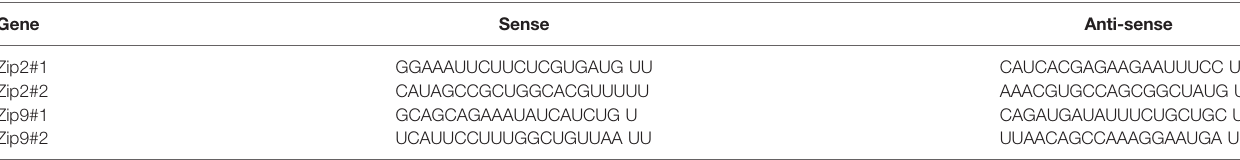
TABLE 2 | siRNA sequence used for transfection.